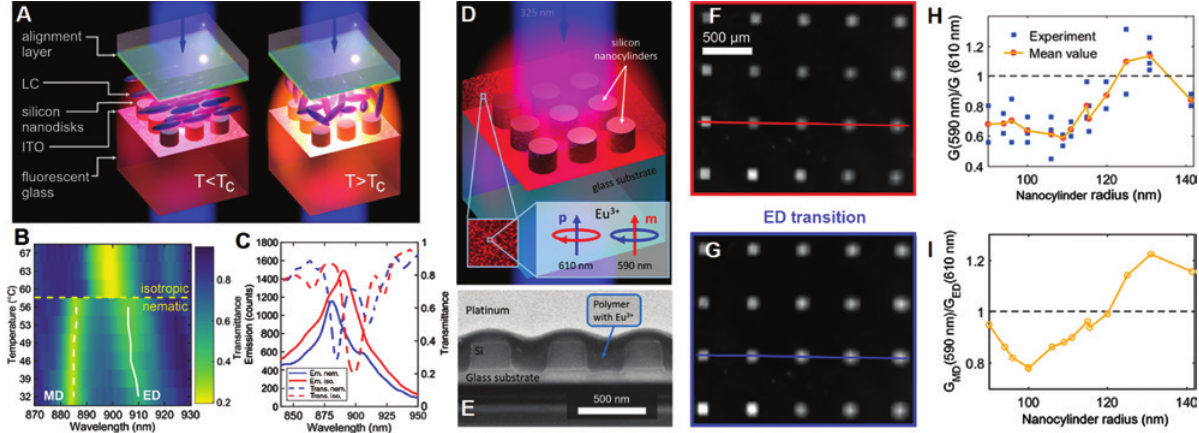
Figure 19: Dynamic control of emission and magnetic emission enhancement. (A) Schematic of a light-emitting silicon nanocylinder metasurface integrated into a nematic liquid crystal cell for temperature tuning. (B) Measured temperature dependent linear-optical transmittance spectra of the metasurface, showing a drastic change as the liquid crystal undergoes a phase transition from nematic to isotropic at its critical temperature T . (C) Measured fluorescence spectra of the metasurface c